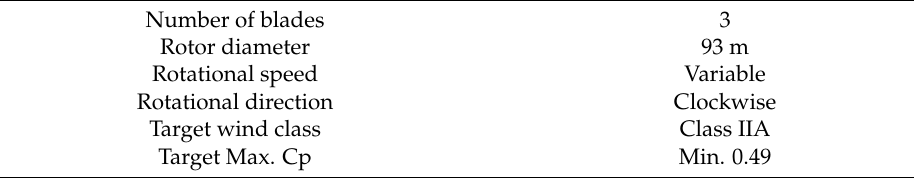
Table 1. Design specifications of the rotor blade.